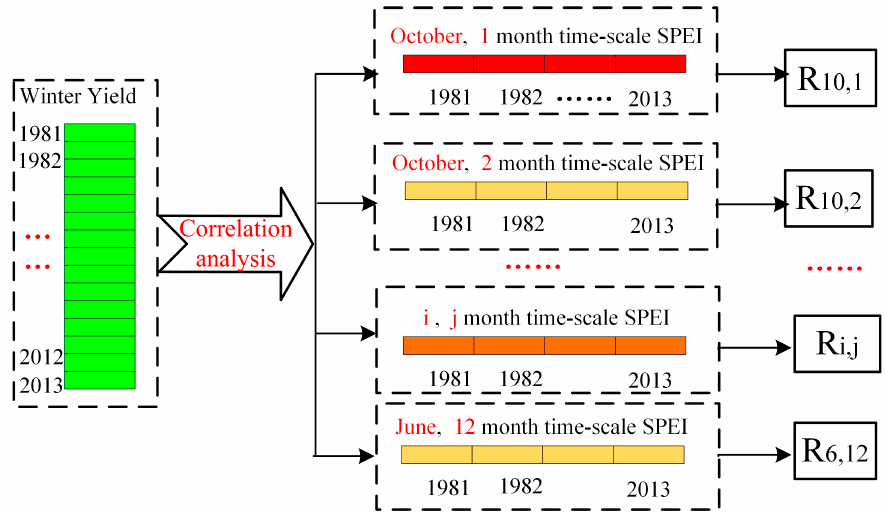
Figure 4. The correlation analysis in one special station. i is the month which belongs to the winter wheat growing season, j represents the time ‐ scale of drought, ranging from 1 to 12 months; R i,j is the Pearson correlation between Yield and the ith month SPEI with time ‐ scale of j.